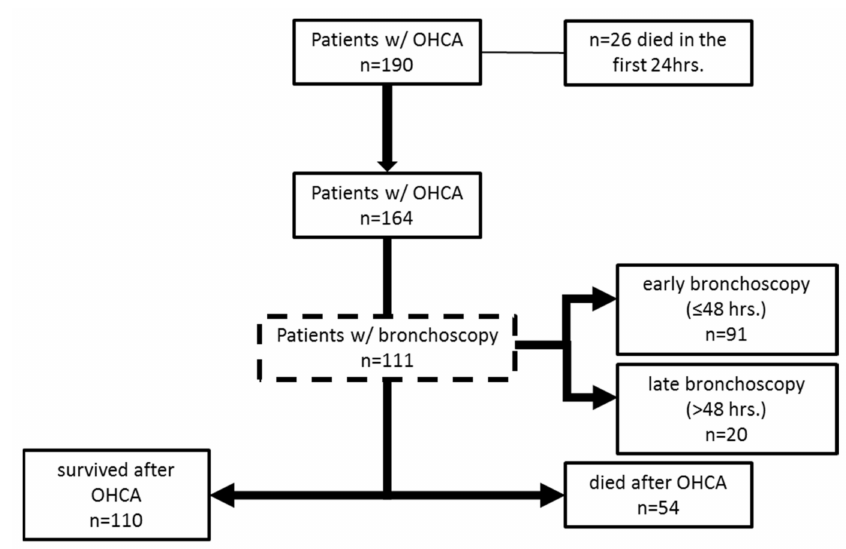
Figure 1. Patient flow diagram.